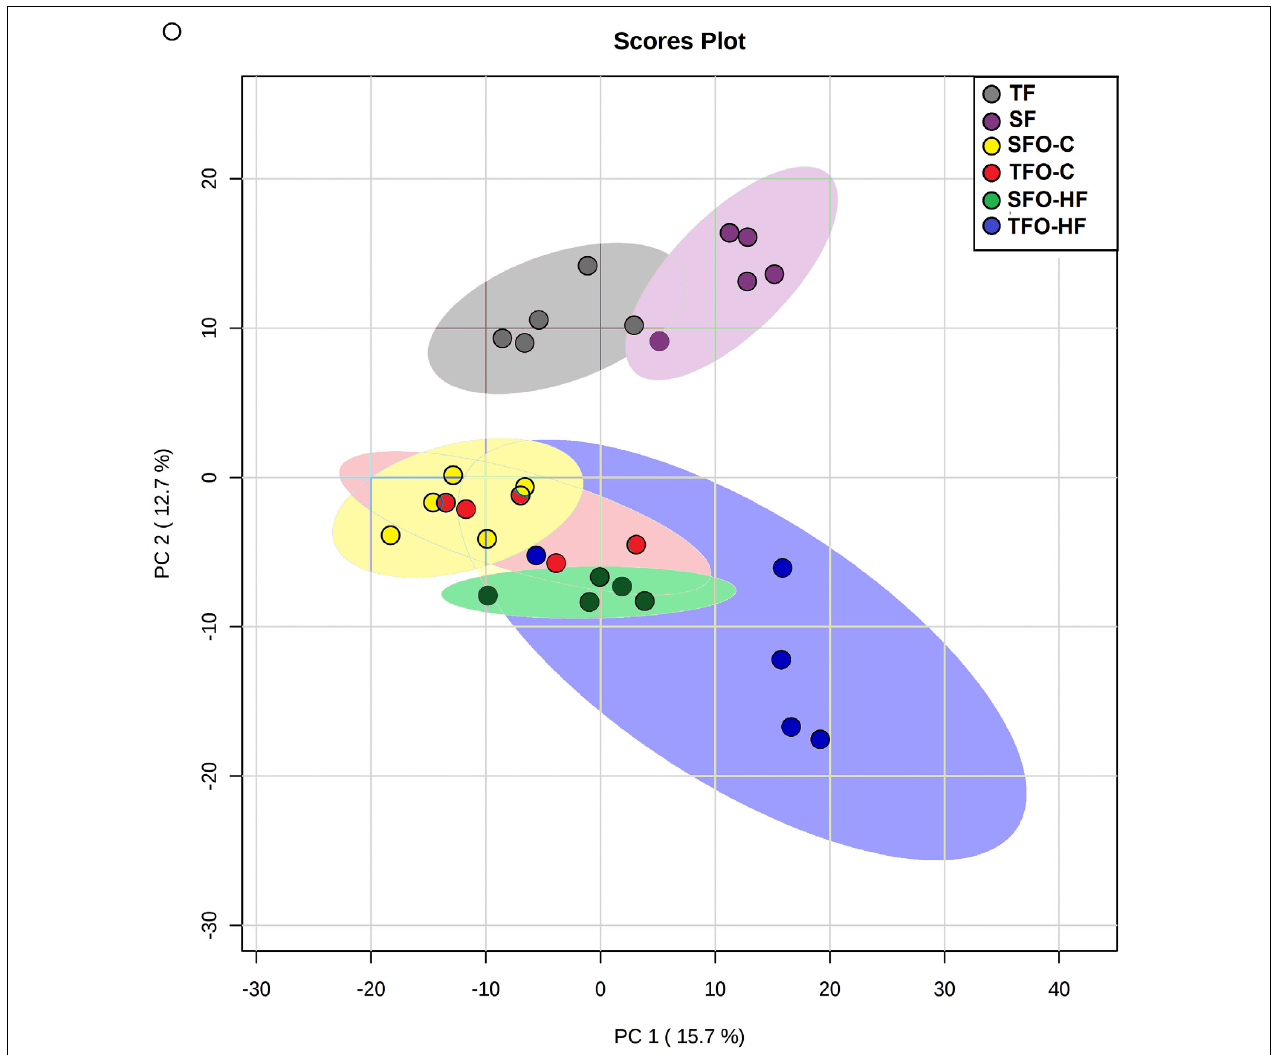
FIGURE 2 | The results of Principal Components Analyses (PCA). Score plot of proteomic data set acquired by Nano-LC-MS/MS of the six biological groups: SF, sedentary fathers (gray); TF, trained fathers (purple); SFO-C, offspring from sedentary fathers, exposed to control diet (yellow); TFO-C, offspring from trained fathers exposed to control diet (red); SFO-HF, offspring from sedentary fathers exposed to high-fat diet (green); TFO-HF, offspring from trained fathers exposed to a high-fat diet (blue). Each animal is represented by individual